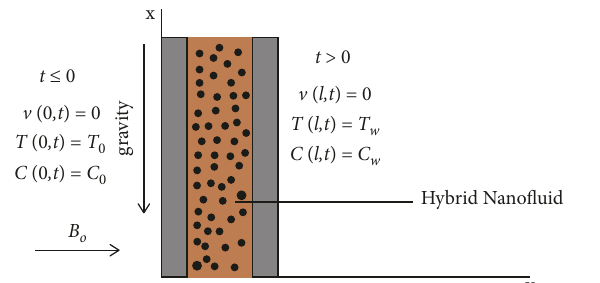
Figure 1: Formation of microchannel and coordinate